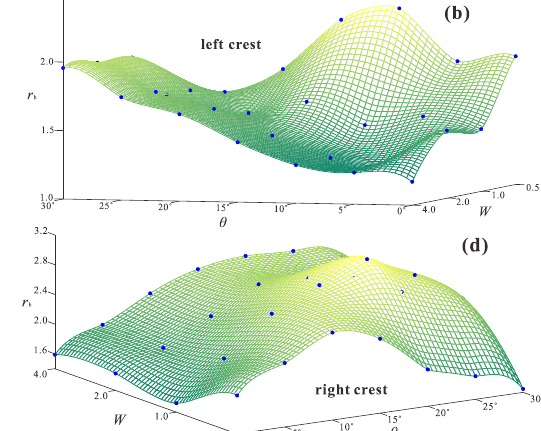
Figure 22. Variations of the horizontal amplification ratios ( r h ) of PGA at the observation points (( a ) left toe, ( b ) left crest, ( c ) right toe and ( d ) right crest) with varied angles of wave incidence at different slope widths.